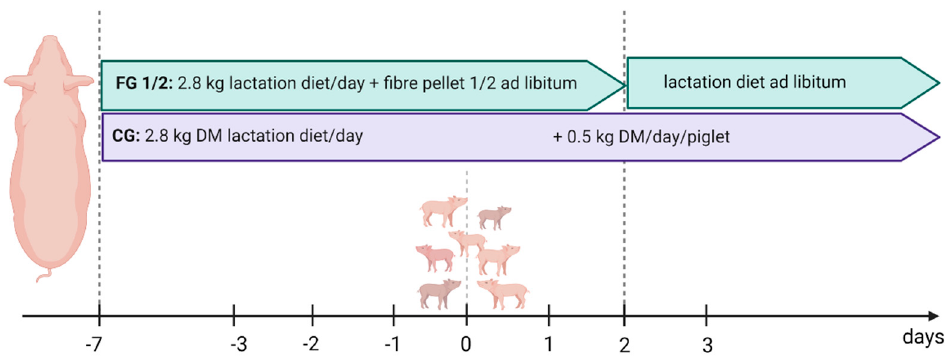
Figure 1 : Feeding scheme of the trial and control groups during the experimental phase (figure was created with BioRender.com, accessed on 23 December